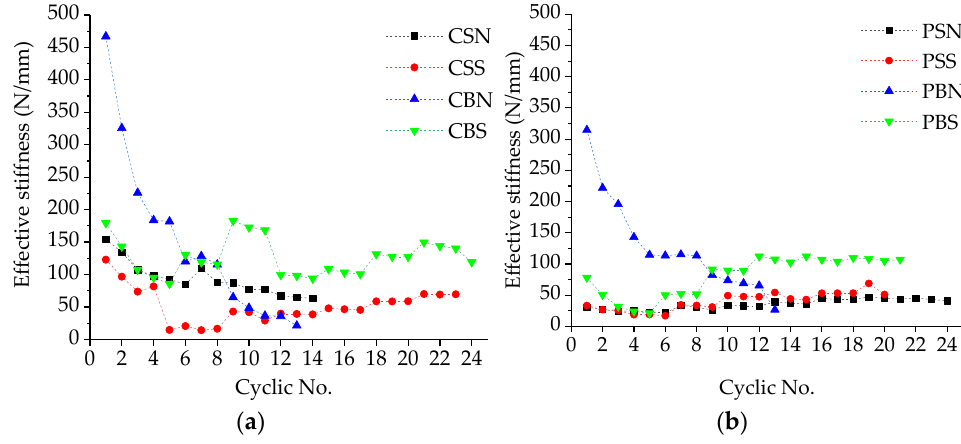
Figure 8. Effective stiffness of the test specimens: ( a ) Perpendicular joints; ( b ) Parallel joints.